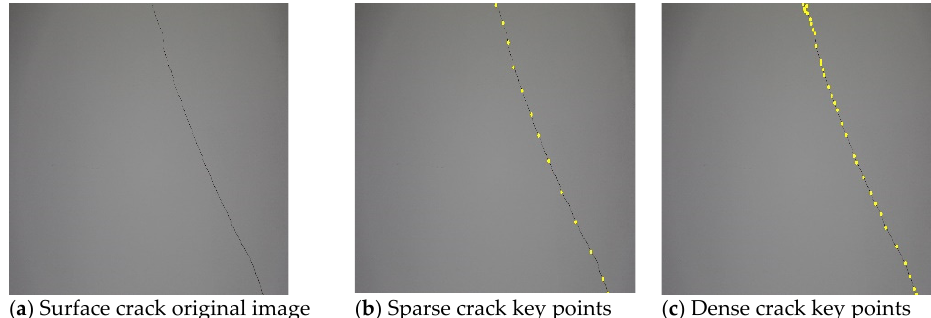
Figure 2. Different crack key points can represent the same